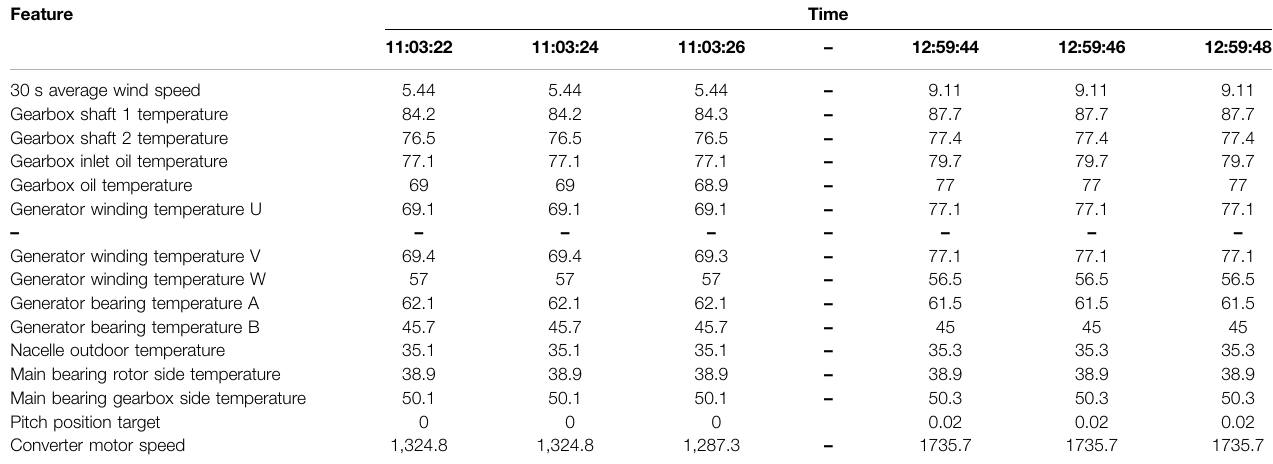
TABLE 2 | Part of the raw data of wind turbines on February 27, 2018. Feature